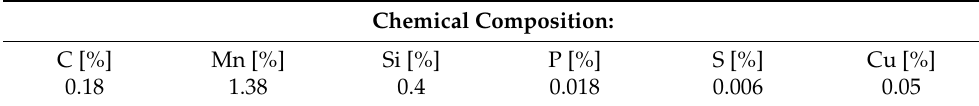
Table 2. Chemical composition of the studied material.